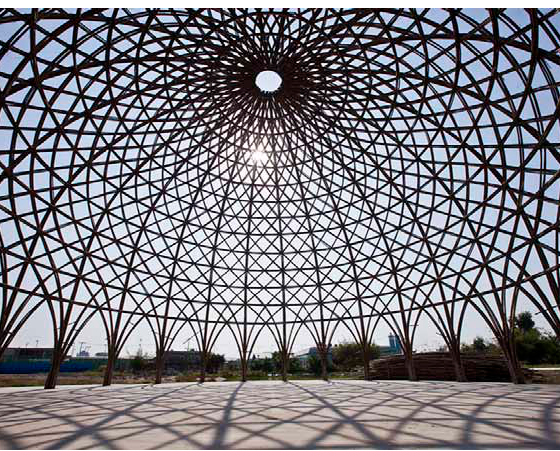
fig. 3. Bamboo Domes by Vo Trong nghia architects